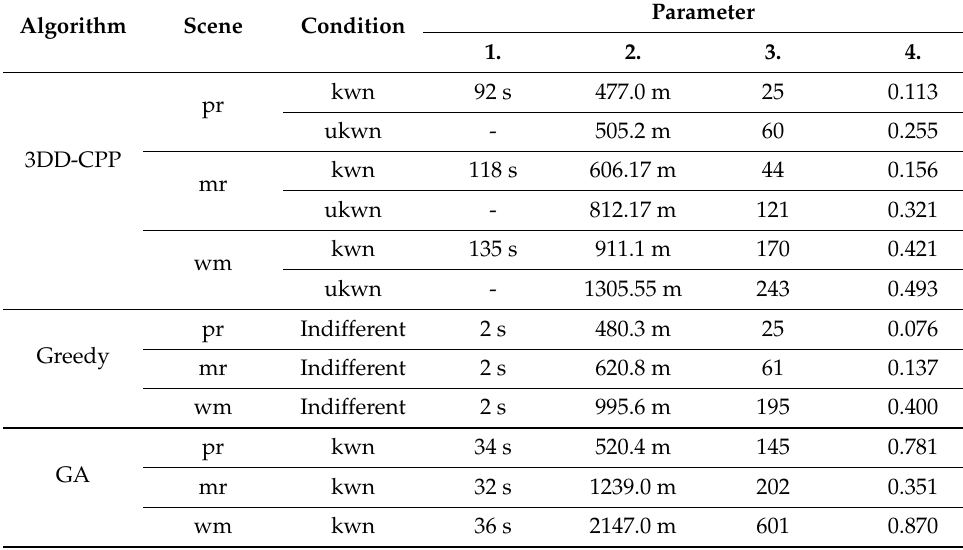
Table 3. Quantitative results from the evaluated methods: (1.) Computational time (s), (2.) total path length (m), (3.) energy consumption (w), (4.) path